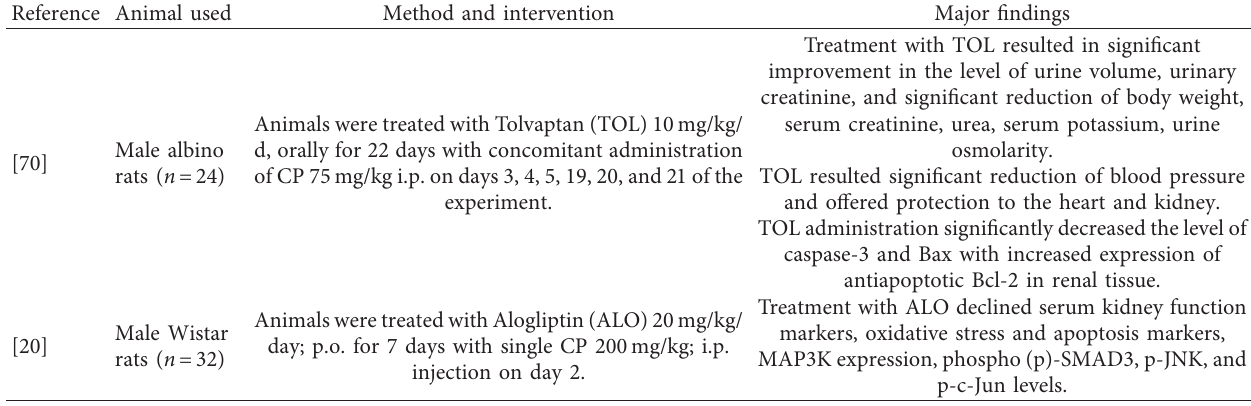
Table 2: The effect of currently available drugs against cyclophosphamide-induced nephrotoxicity. Reference Animal